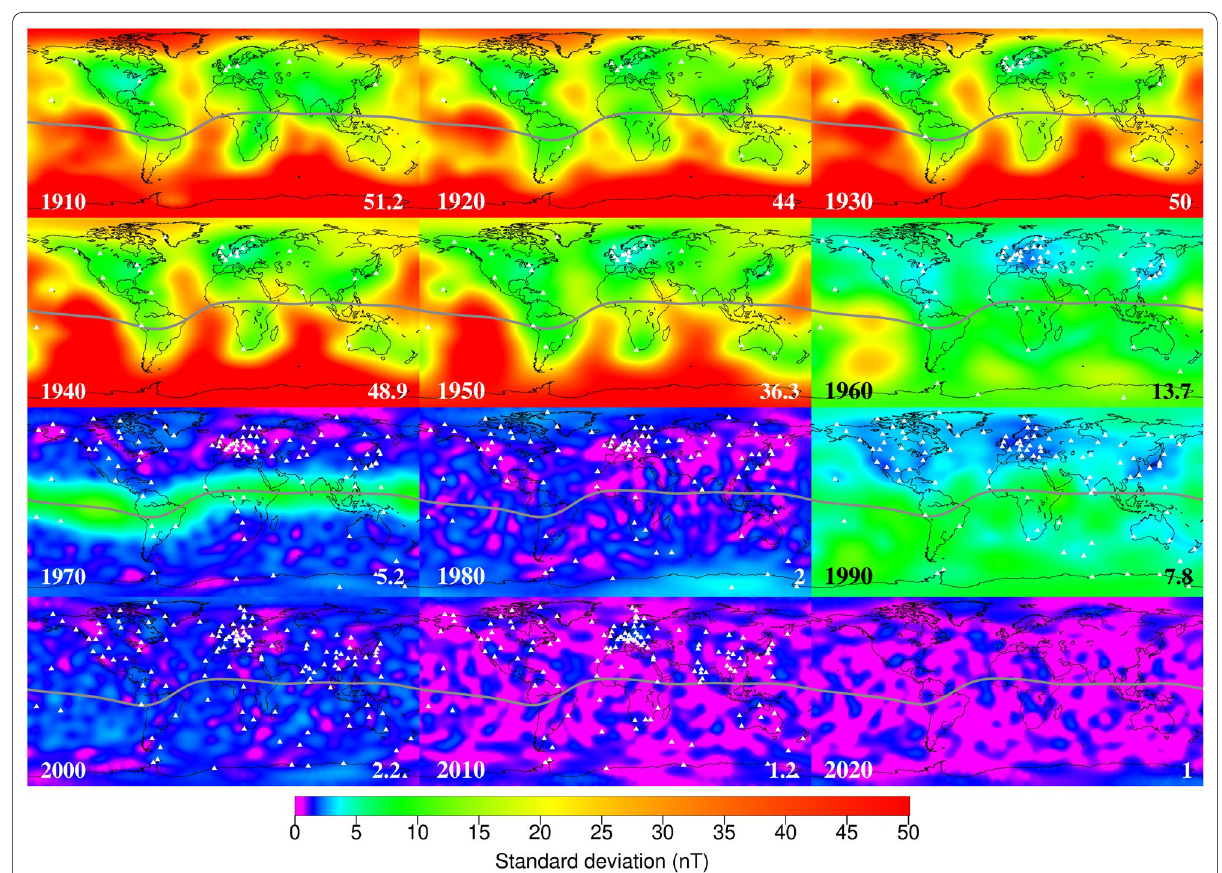
Fig. 2 Standard deviation associated with the radial component at the Earth’s surface of the sum of the core field and the lithospheric field expanded up to spherical harmonics degree ℓ = 20 . Each panel corresponds to a different epoch which is displayed on their bottom left. Isocontours show the mean B r = 0 solution. White triangles represent the locations of ground‑based observatories available at the presented epochs. On the bottom right of each map is indicated the r.m.s standard deviation ¯ σ in